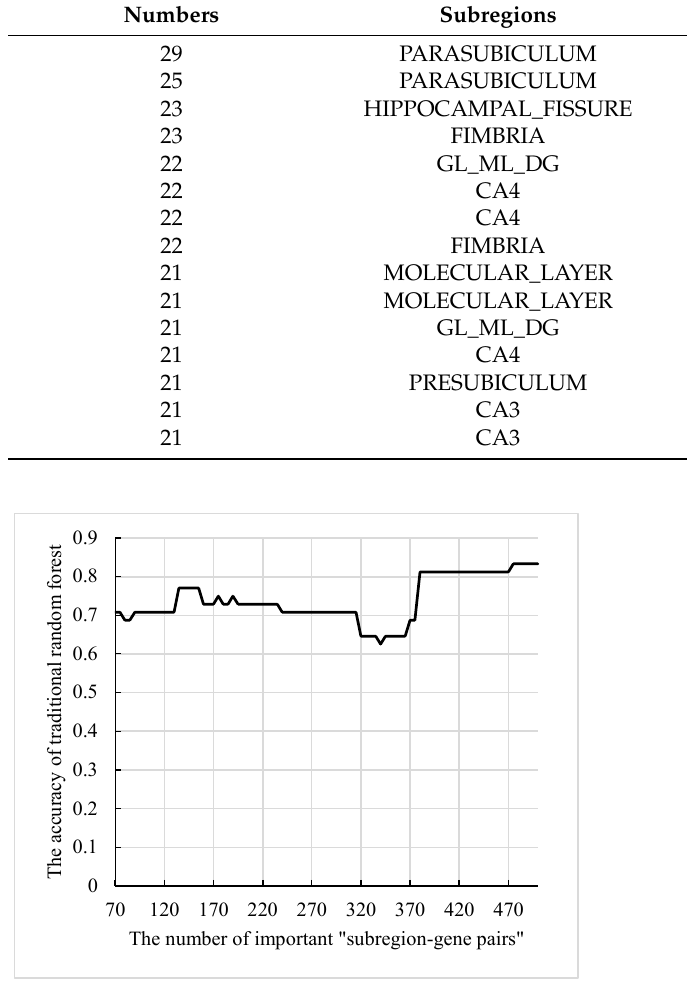
Figure 10. The ability of the traditional random forest to classify the subsets.